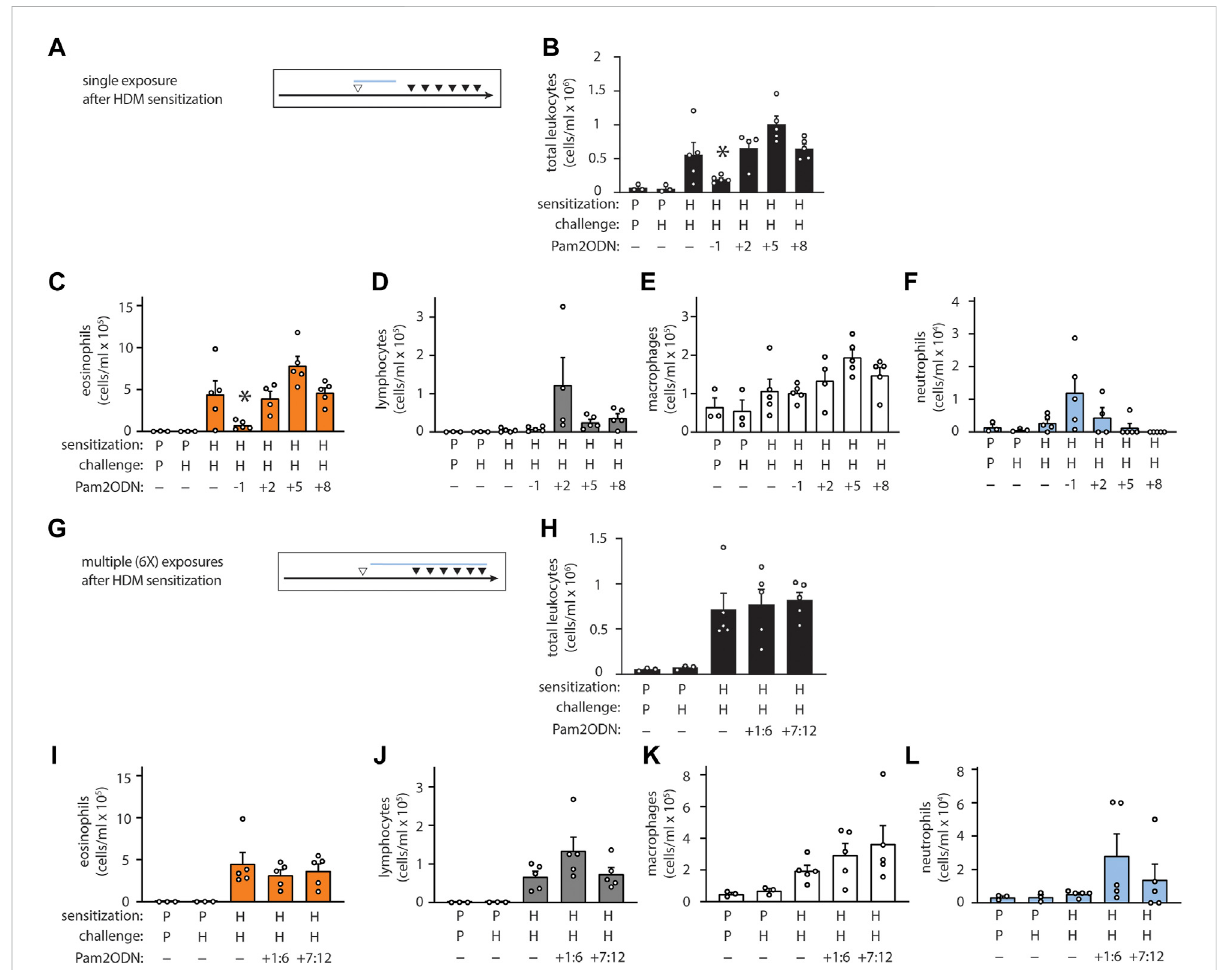
FIGURE 2 Pam2-ODN prevents sensitization to HDM. (A,G) Quanti fi cation of leukocytes in lung lavage when a single Pam2-ODN treatment was administered before or after sensitization to HDM (N = 3-5 mice). (B,H) Quanti fi cation of lung leukocytes when 6 consecutive daily Pam2-ODN treatmentswereadministeredaftersensitizationtoHDMduringthe fi rstweek(days+1:6)orconcurrentlywithchallenge(days+7:12).Quanti fi cation of leukocytes in lung lavage for (C,I) eosinophils, (D,J) lymphocytes, (E,K) macrophages, (F,L) neutrophils. Pictograms show blue bar at the approximate range of Pam2-ODN exposure in relationship to sensitization and challenge. Bars show mean +/- SEM. P* < 0.05 by one-way ANOVA with Dunnett ’ s test for multiple comparisons against [HDM/HDM] control. p = PBS. H =